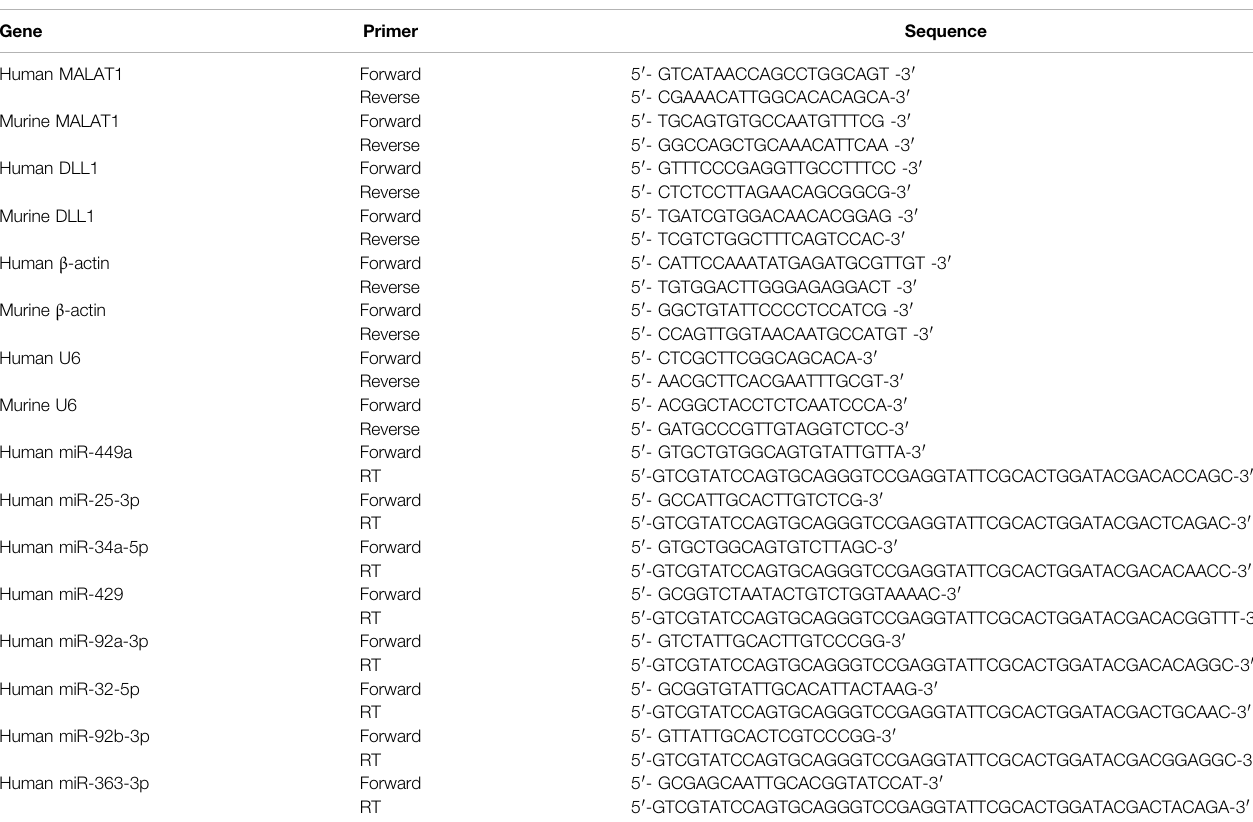
TABLE 1 | Primers used in this